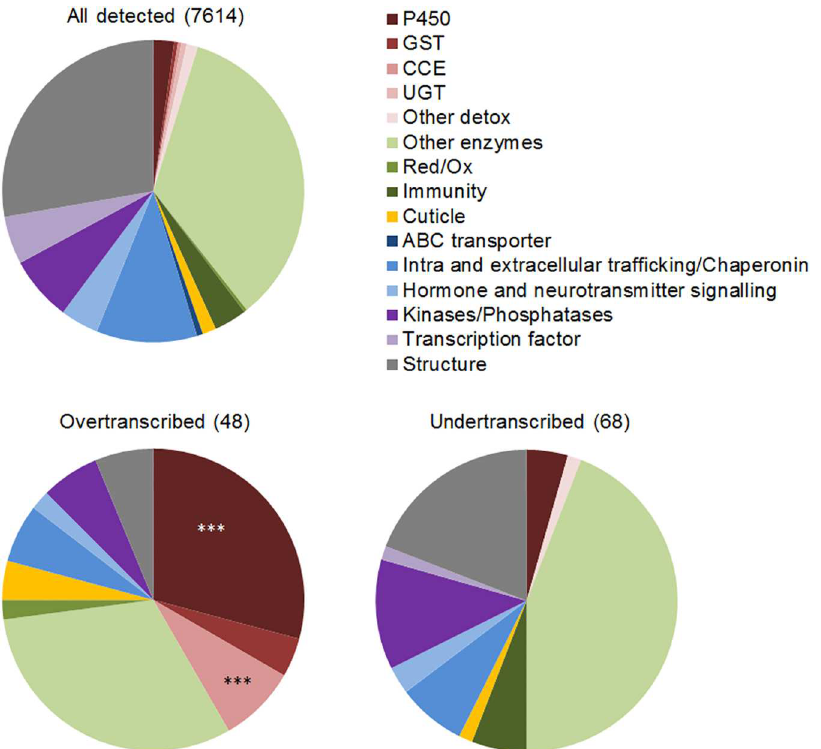
Fig 1. Gene families affected by DE genes in resistant populations. Genes showinga fold change (cid:21) 3 in either directions, and q-value (cid:20) 0.001 in any resistant population as comparedto all susceptiblestrains were considered differentiallyexpressed. Biologicalcategoriesmostly affected were identified by comparing their proportionbetweenall genes detected by RNA-seq and those being differentiallyexpressedusing a one- sided Fisher’s exact test ( *** p (cid:20)